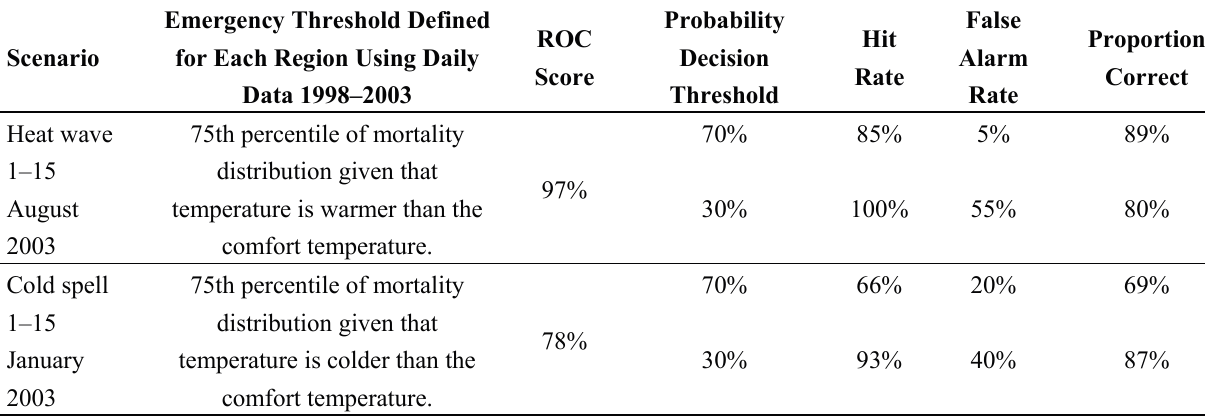
Table 1. Evaluation of heat waves and cold spell scenarios given pre-defined emergency and probability decision